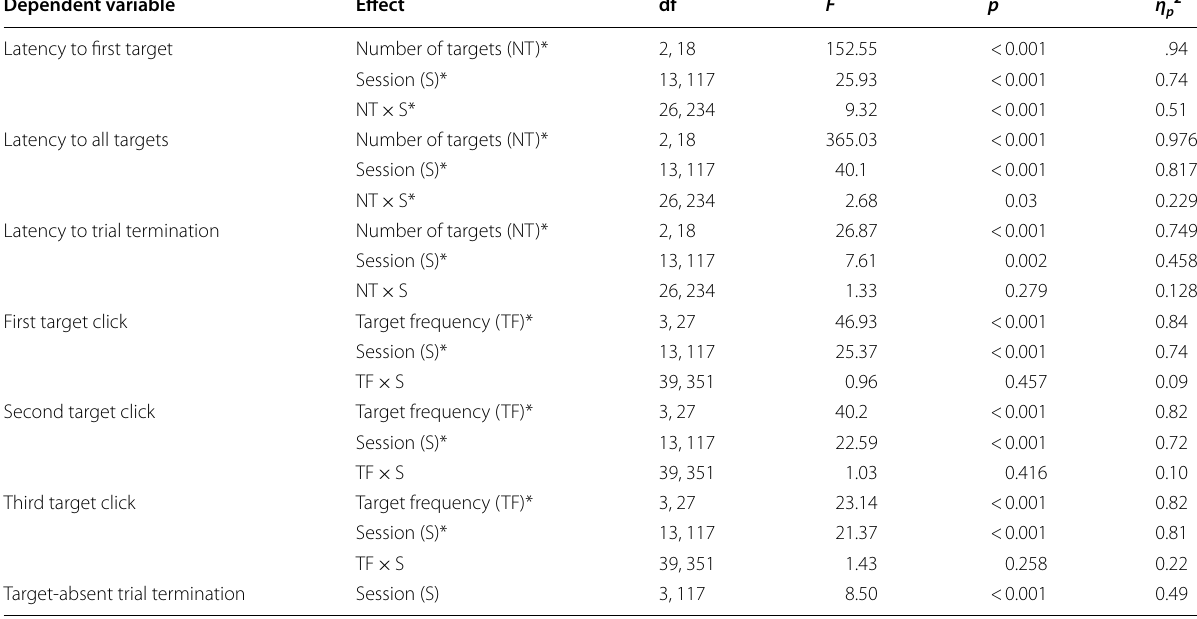
Table 3 Results of analyses on raw value RT